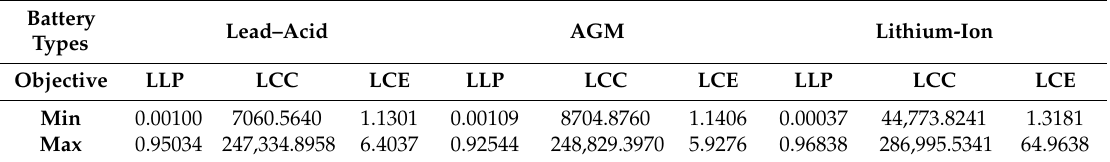
Figure 10. PF solutions for three lead – acid, AGM, and lithium-ion batteries using the PESA-II method. Table 7. Minimum and maximum values of three objectives were found on the basis of the PESA-II